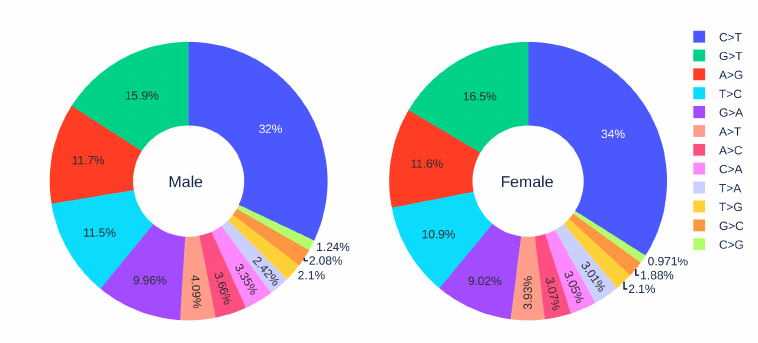
Figure 2. The distribution of 12 SNP types among unique mutations in the SARS-CoV-2 genome isolates from two gender groups. The total number of records in the female group is 5762 and the total number of records in the male group is 7012.